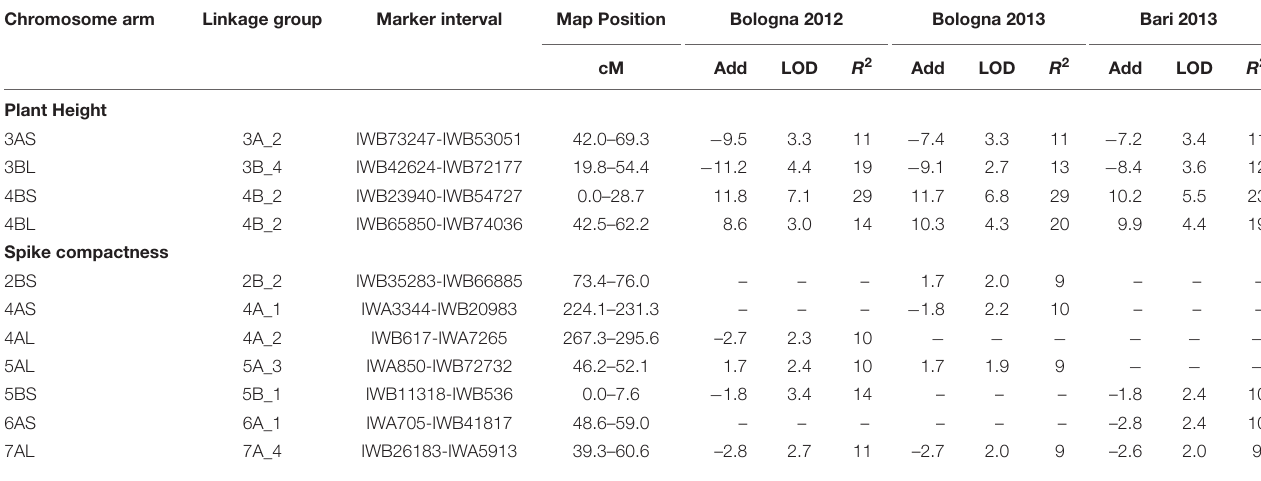
TABLE 7 | List of QTL for morphological traits (plant height and spike compactness) detected by inclusive composite interval mapping (ICIM) in the durum wheat RIL population derived from the cross between resistant 02-5B-318 line and susceptible cv. Saragolla; for each marker one of the co-migrating loci at the same map position is